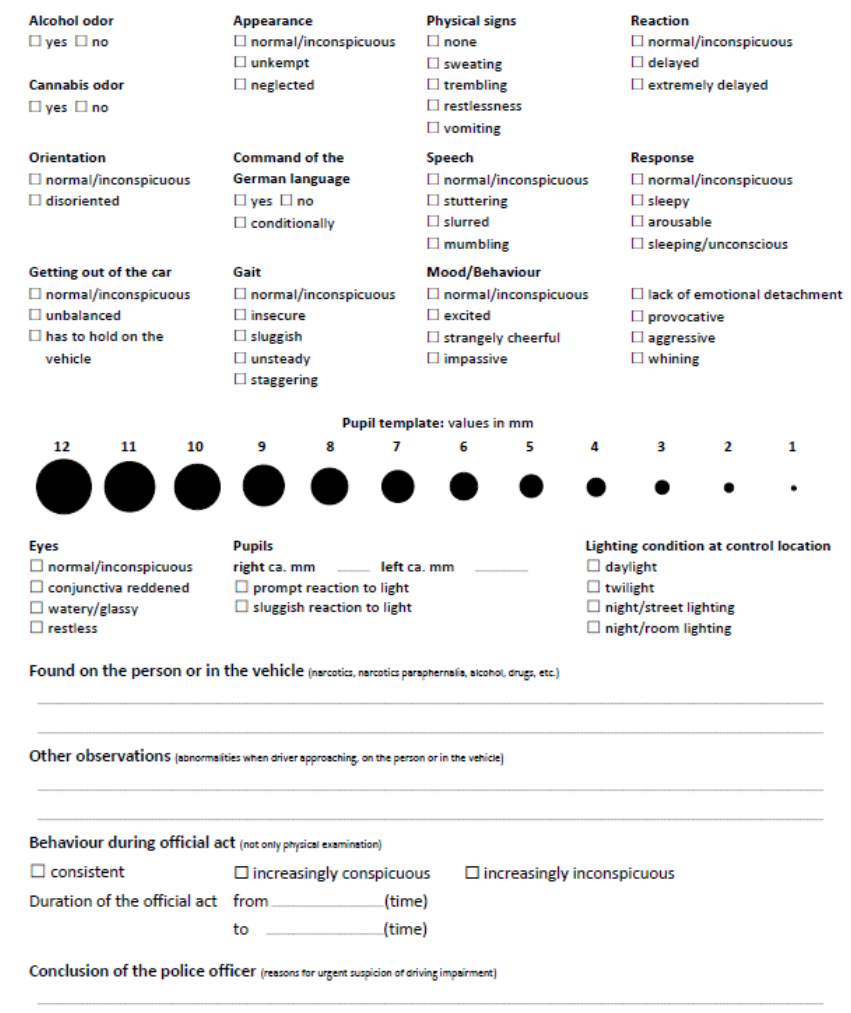
Figure 1. The original VERIFY checklist, translated from German.